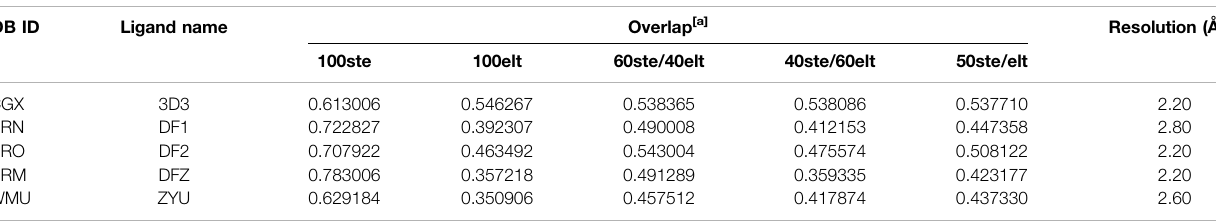
TABLE 2 | Overlap similarity values between Roc-A and native ligands of complexes analyzed.